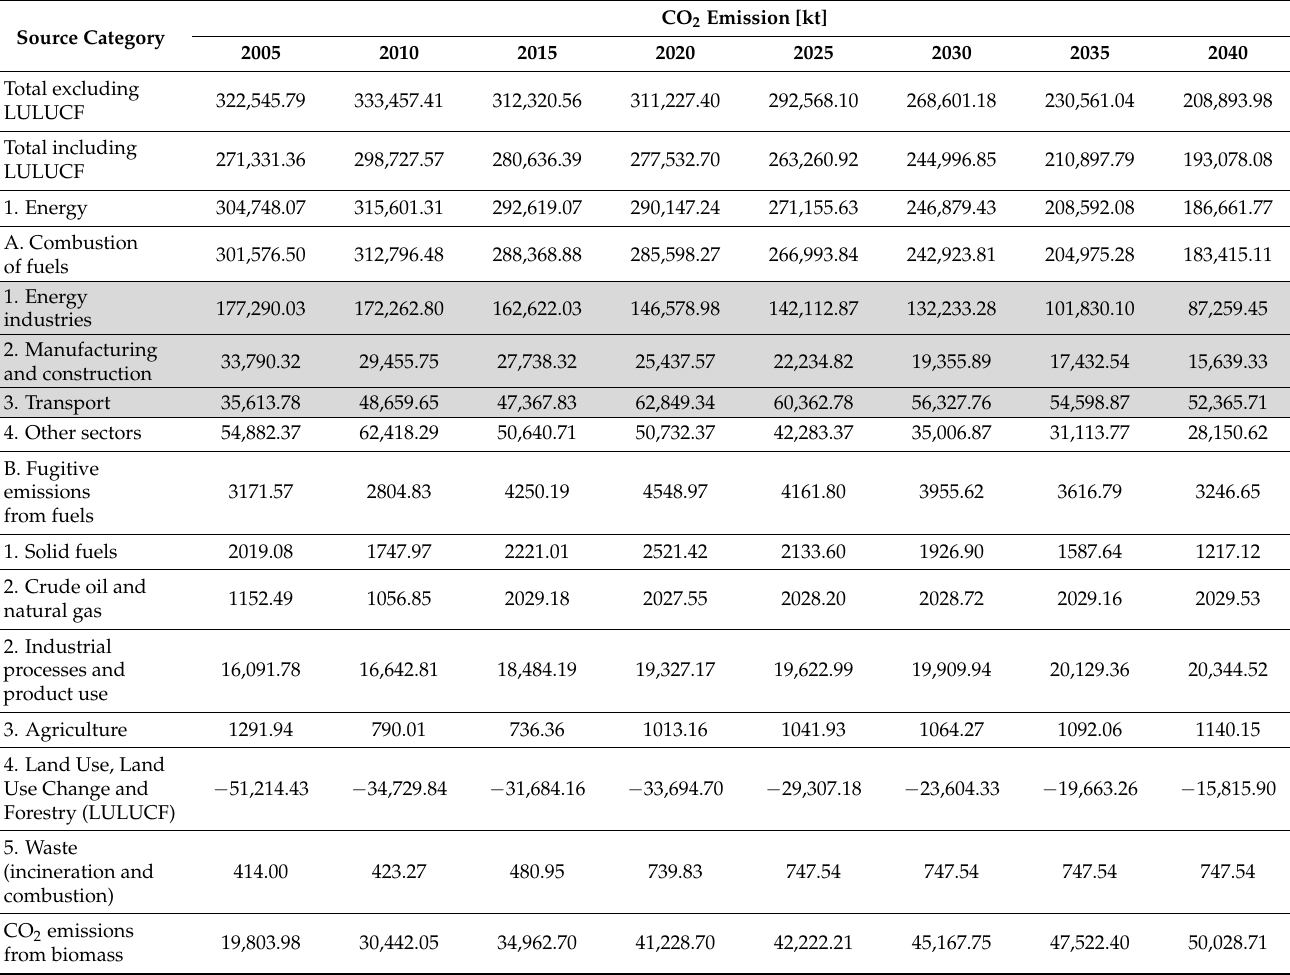
Table 1. Projected CO 2 emissions by sector for the Energy and Climate Policy scenario